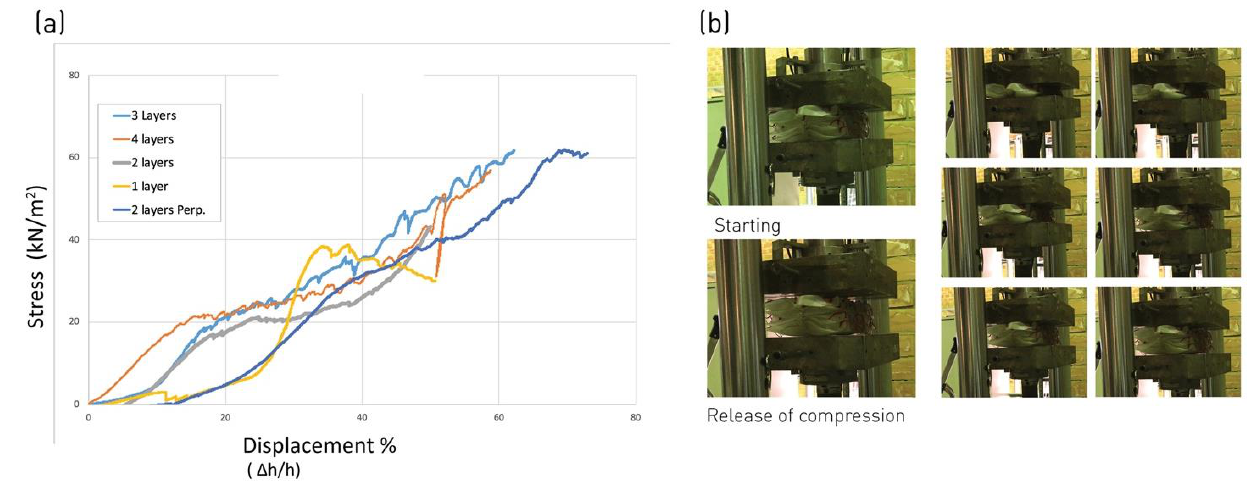
Figure 5. Compressive tests, distributed load. ( a ) Stress-displacement curves over five samples of different layer composition. ( b ) Sample during test: application of force and release of compression stress.